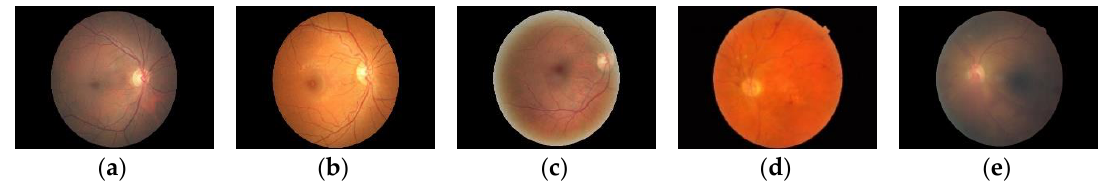
Figure 1. Random samples of different grades of diabetic retinopathy. ( a ) grade 0, ( b ) grade 1, ( c ) grade 2, ( d ) grade 3, and ( e ) grade 4.